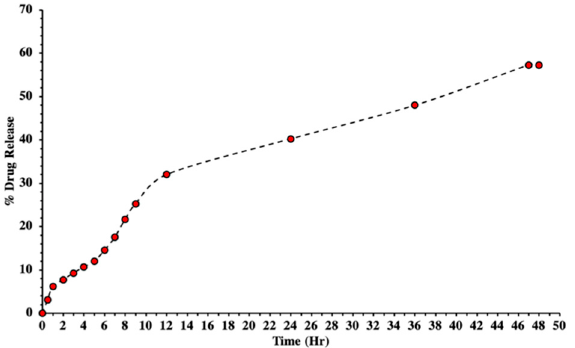
Figure 12. In vitro percent of drug release from PEGylated chitosan nanoparticle formulations.